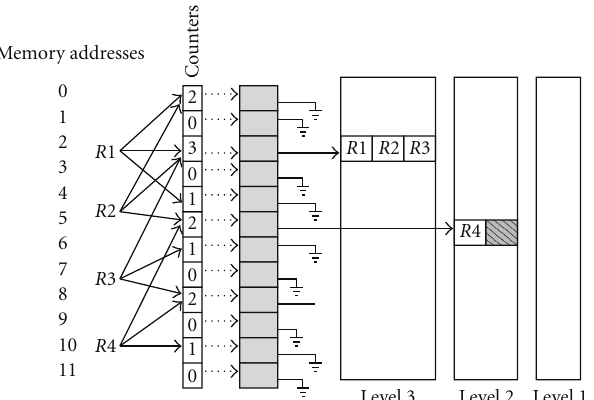
Figure 1: The hash table architecture using cached counting Bloom filters.